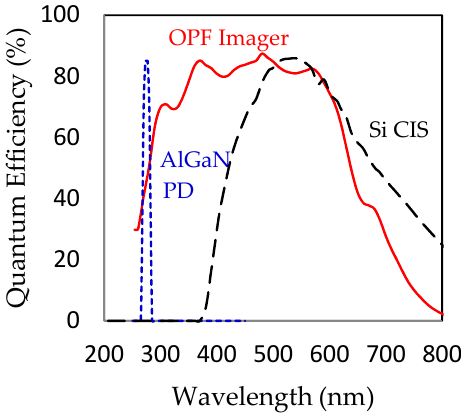
Figure 1. Quantum efficiency spectra of the present OPF CMOS imager (red), a Si CIS (black) and an AlGaN photodiode (blue) [7].